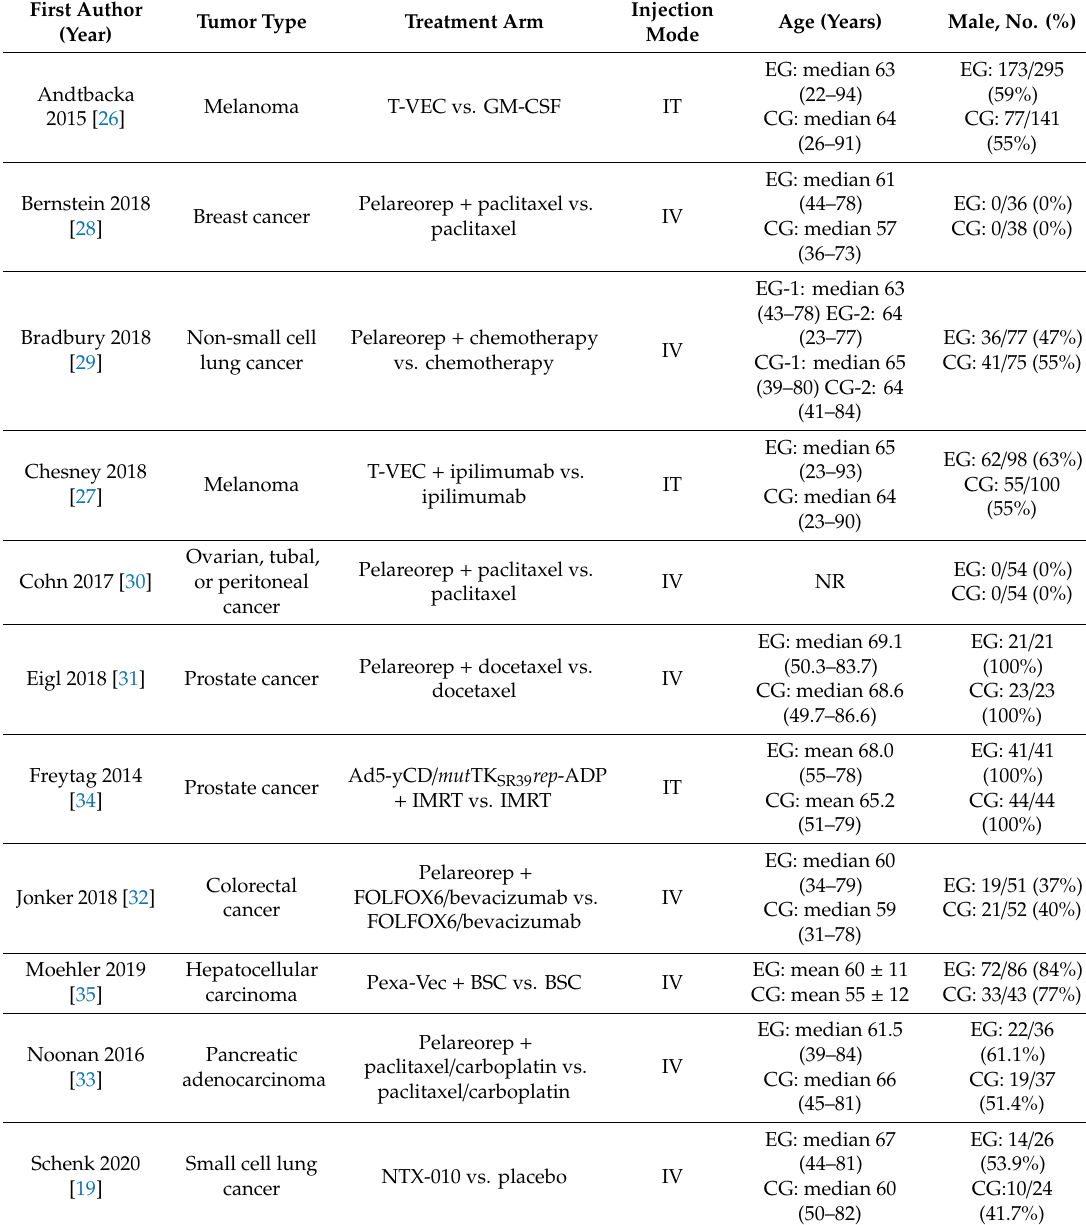
Table 1. Characteristics of the RCTs included in this